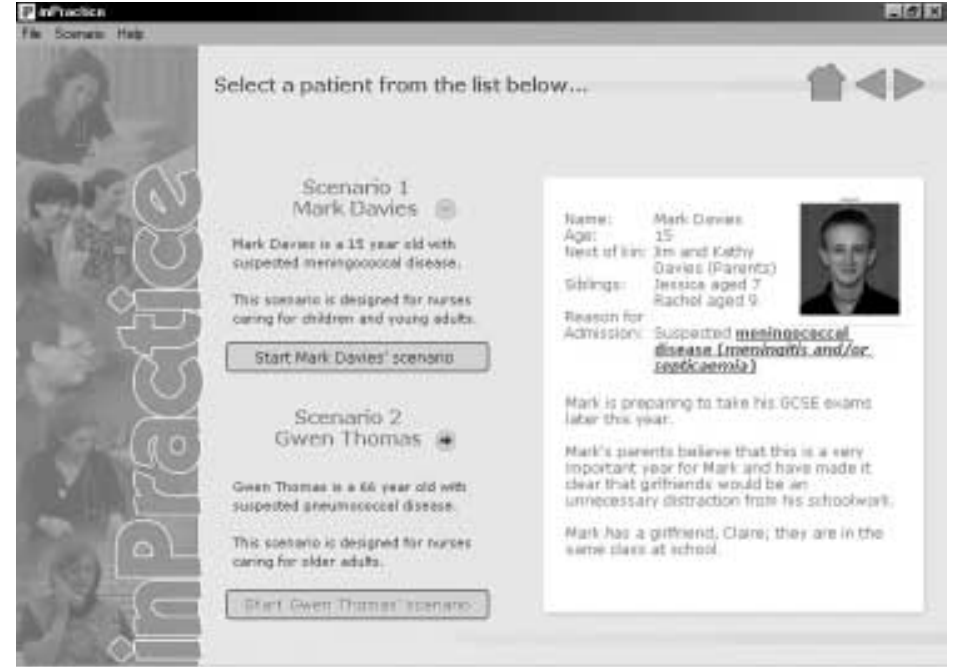
Figure 1. A typical introductory screen in an inPractice